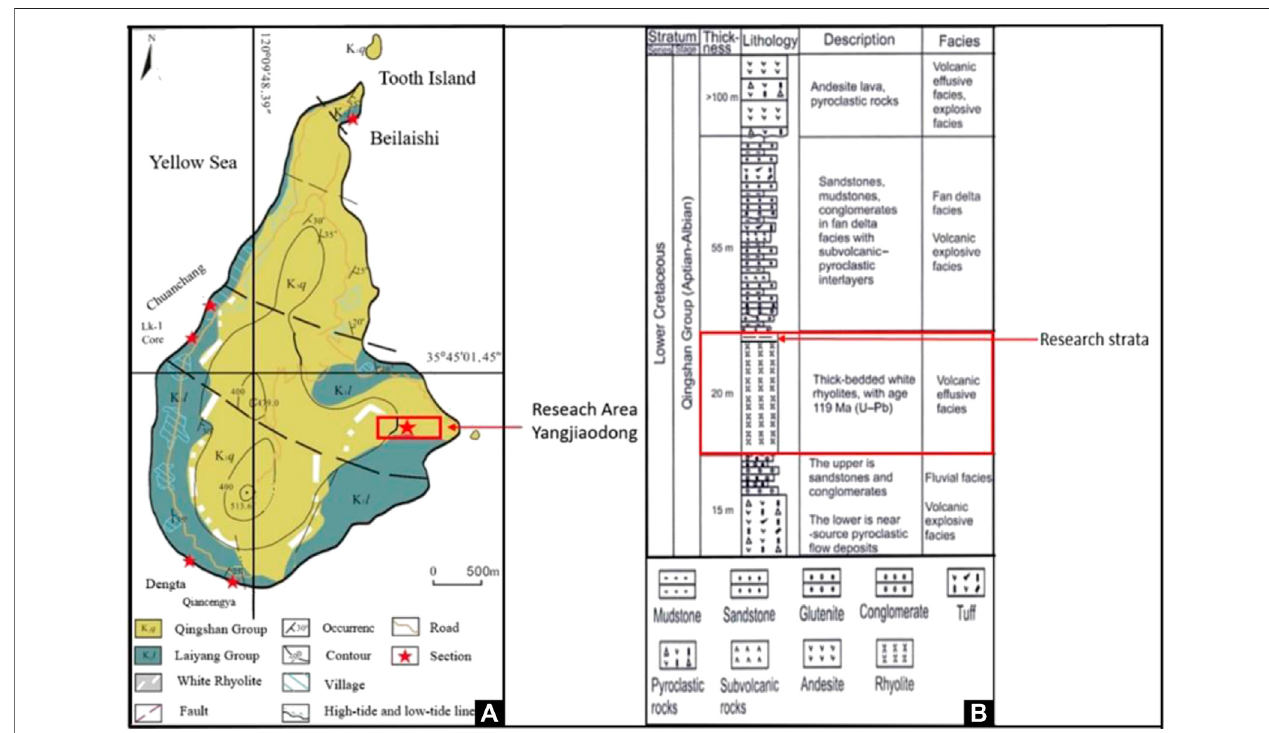
FIGURE 2 | Geological survey of Lingshan Island (Revised after Luan, 2010) and pro fi le of the Qingshan Group strata in the Yangjiaodong section of Lingshan Island, Shandong Province (Revised after Peng, 2017).